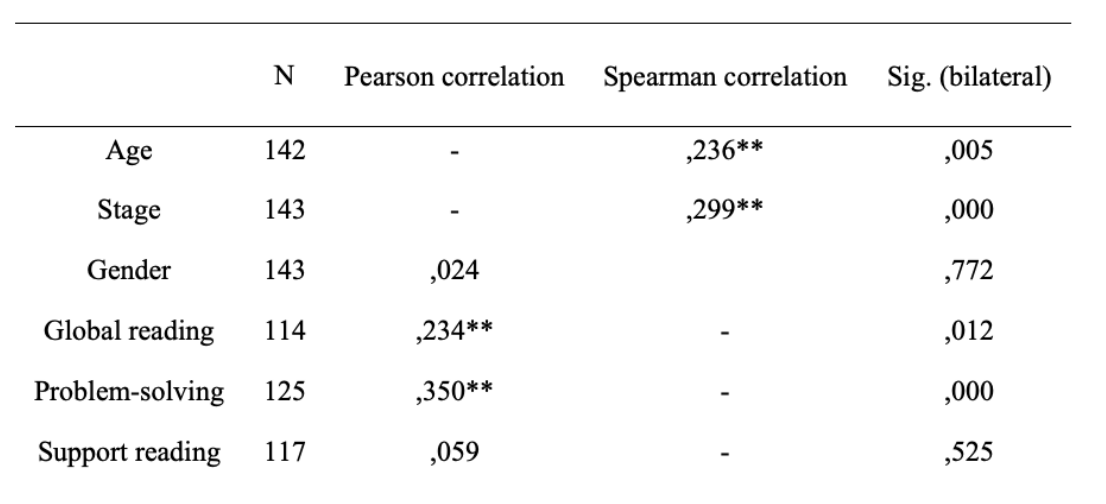
Table 7. Bivariate correlation between the independent variables and the CompLEC dependent